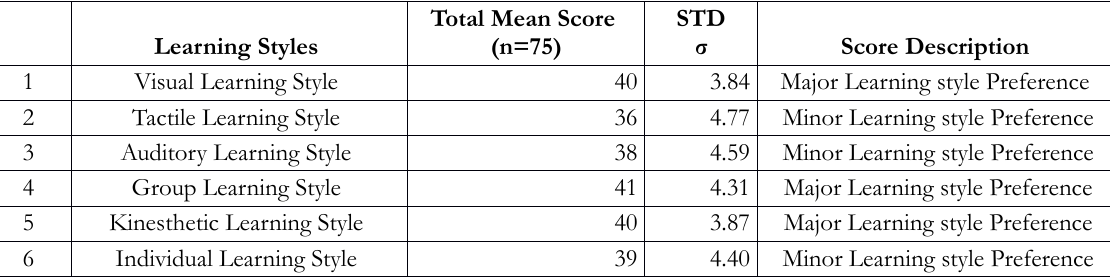
Table 1. Learning Style Preference Scores of the